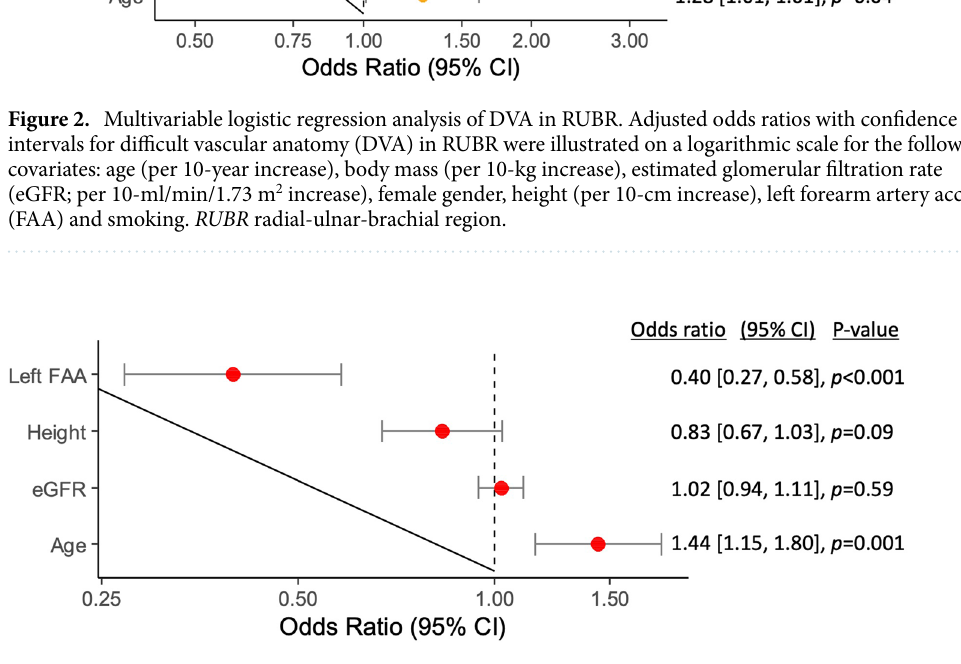
Figure 3. Multivariable logistic regression analysis of DVA in SIAR. Adjusted odds ratios with confidence intervals for difficult vascular anatomy (DVA) in SIAR were illustrated on a logarithmic scale for the following covariates: age (per 10-year increase), estimated glomerular filtration rate (eGFR; per 10-ml/min/1.73 m 2 increase), height (per 10-cm increase) and left forearm artery access (FAA). SIAR subclavian-innominate-aortic